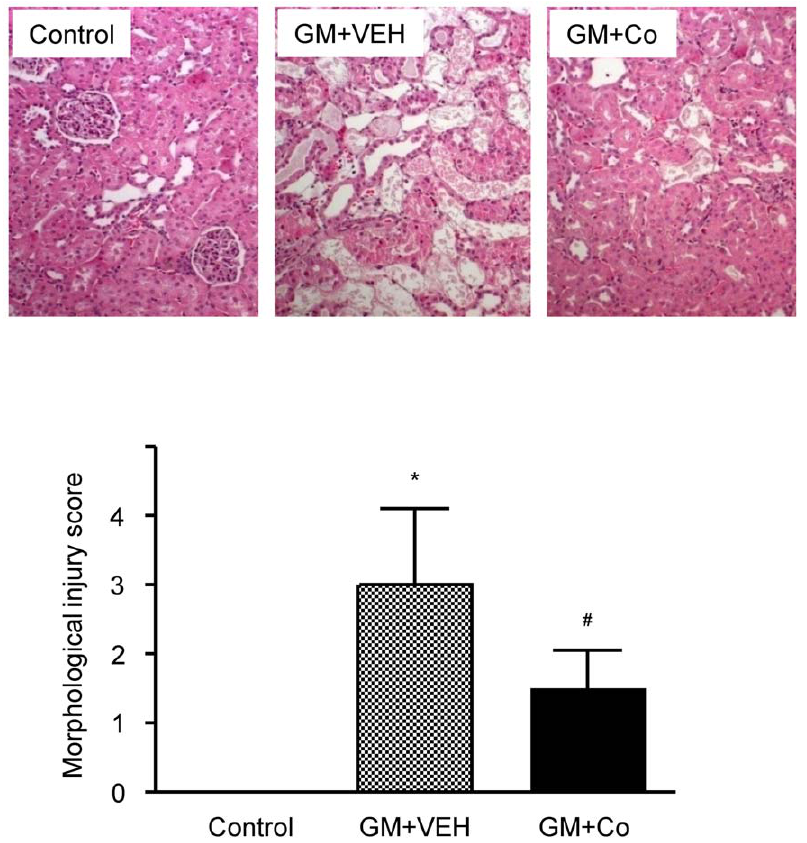
Figure 5. Effects of gentamicin and cobalt on renal histology. Representative pictures of H&E-stained renal cortical areas and morphological injury scores. The results are expressed as the mean 6 s.d. *Significantly different with respect to control rats. # Significantly different with respect to the rats treated with gentamicin and vehicle. * # P , 0.05. GM + VEH, gentamicin and vehicle treatment; GM + Co, gentamicin and cobalt treatment. Magnification 6 200.